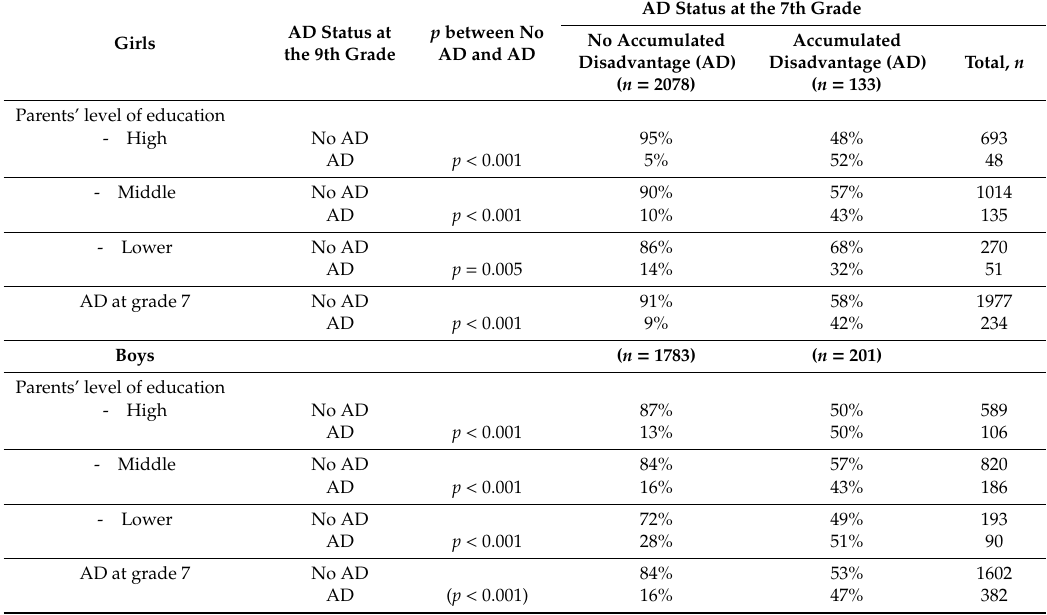
Table A1. Accumulated disadvantage (AD) at the 9th grade (%) by gender, parents’ level of education and AD status at the 7th grade. ( N =